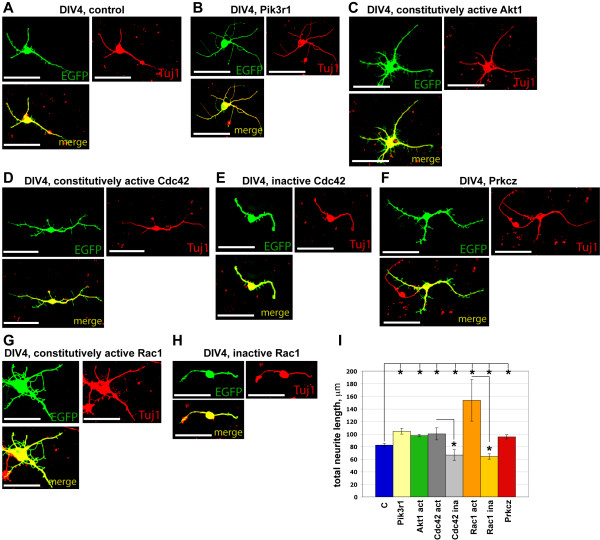
Neurite outgrowth analysis of SVZ/RMS-derived neurons using genetic manipulations. Cultured cells were transfected by both pEGFP and particular gene coding construct. (A) - (H) Examples of overexpression after transfections with control (A), Pik3r1 (B), constitutively active Akt1 (C), constitutively active Cdc42 (D), inactive Cdc42 (E), Prkcz (F), constitutively active Rac1 (G) and inactive Rac1 (H) constructs are shown. (I) Overexpression of constitutively active as well as full-length gene versions increased the total neurite length while inactive gene versions decreased it (* - p < 0.005). Abbreviations: Akt1 act - constitutively active form of Akt1, C - control (pCMV-SPORT6), Cdc42 act - constitutively active form of Cdc42, Cdc42 ina - inactive form of Cdc42, Pik3r1 - full-length Pik3r1 form, Prkcz - full-length PKCζ form, Rac1 act - constitutively active form of Rac1, Rac1 ina - inactive form of Rac1, Tuj1 - tubulin beta III to label immature neurons. Scale bars are 50 μm.